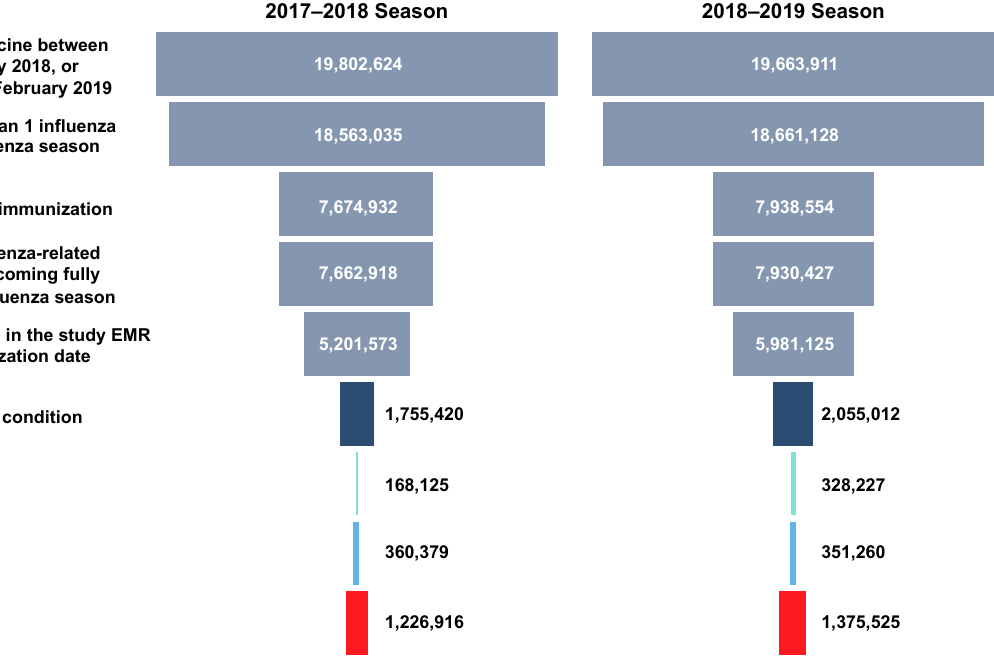
Figure 1. Flow diagram of patient selection process. aIIV3, adjuvanted trivalent inactivated influenza vaccine; EMR, electronic medical record; HD-IIV3, nonadjuvanted high-dose trivalent inactivated influenza vaccine; IIV4, nonadjuvanted quadrivalent inactivated influenza vaccine.